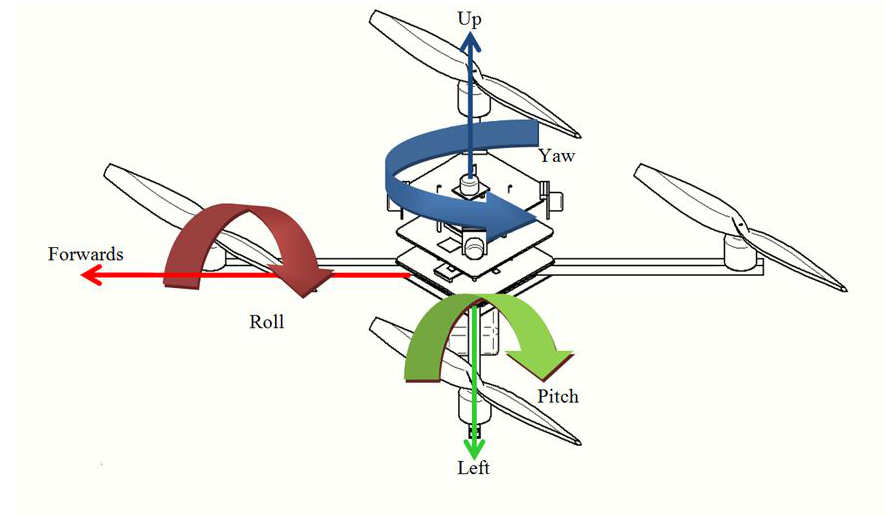
Figure 1. The rotational degrees of freedom of a UAV: roll ( x -axis), pitch ( y -axis) and yaw ( z -axis) [42].